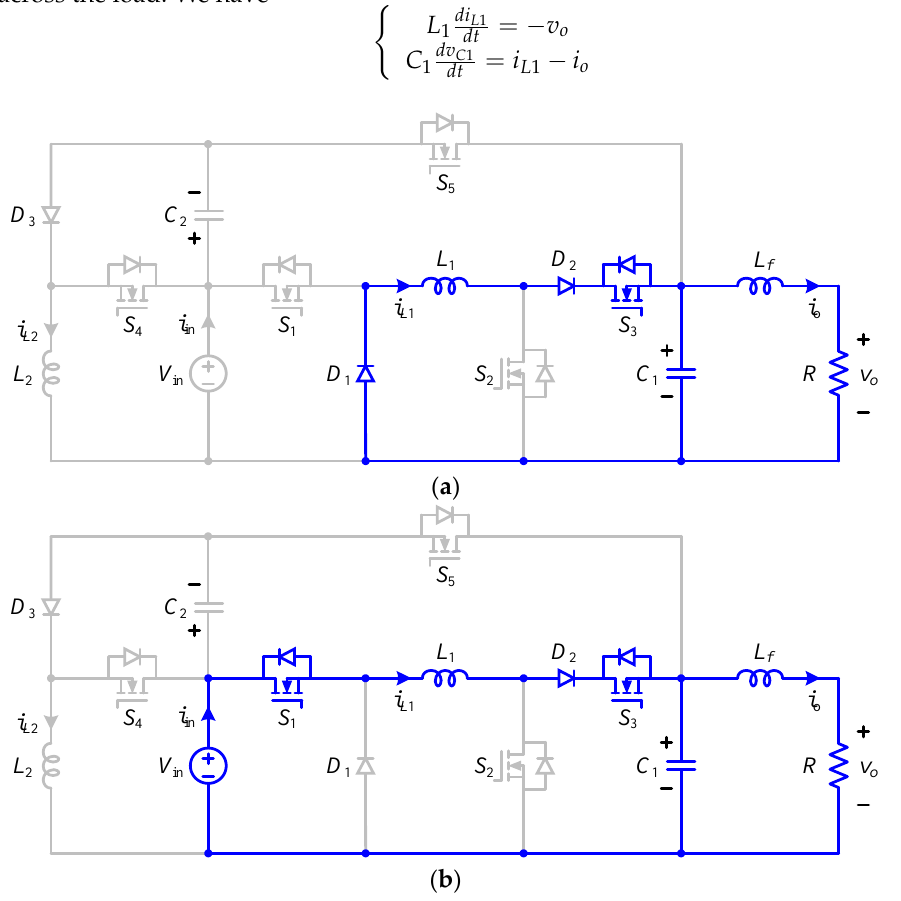
Figure 3. Equivalent circuits of the proposed CGBBI topology in interval 1 when 0 < v o < V in : ( a ) mode 1 and ( b ) mode